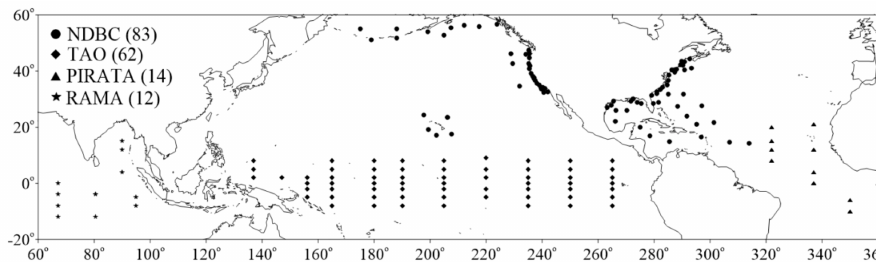
Figure 1. Locations of the National Data Buoy Center (NDBC), Tropical Atmosphere Ocean (TAO), Pilot Research Moored Array (PIRATA), and Research Moored Array for African-Asian-Australian Monsoon (RAMA) moored buoys.